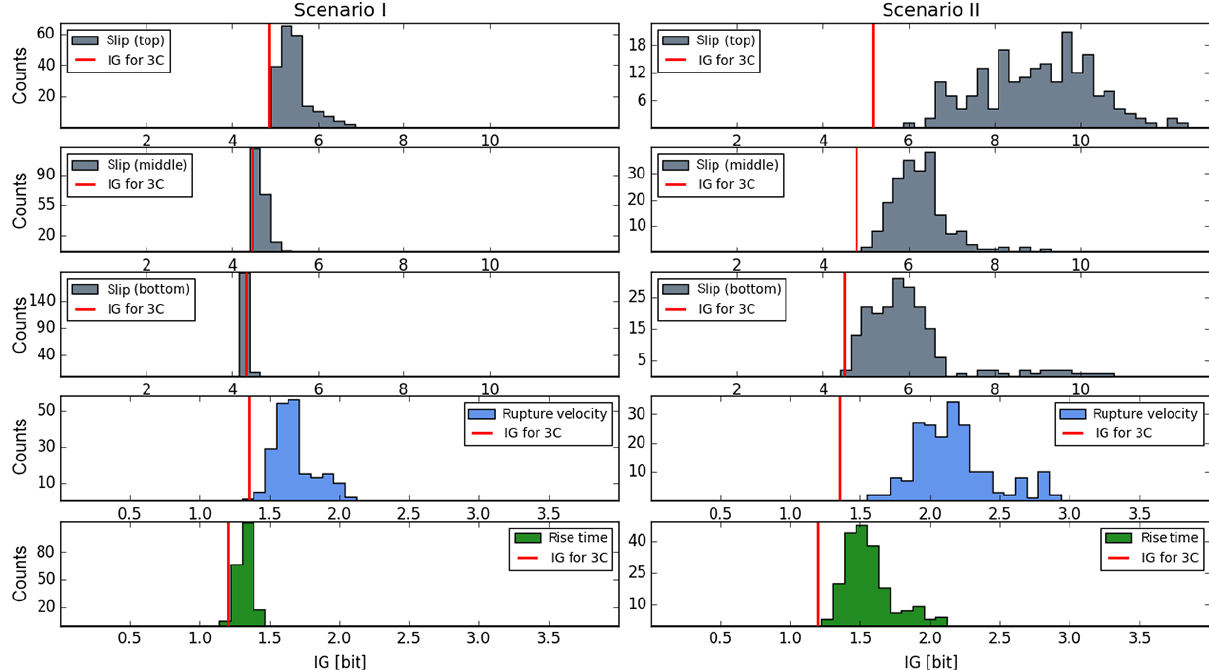
Figure 8. Histograms for the information gain for 200 inversions with random station distribution. The results for a strike-slip fault are shown in the left column and for a dip-slip fault in the right column. We add the information gain for the slip parameters row-wise to better assess the inversion quality dependence with depth. Slip (in gray), rupture velocity (in blue), and rise time (in green) are colored differently to distinguish between the three types of parameters. The statistical analysis validates the previous results. Independent of the choice of receivers (due to the random selection for each inversion) the information gain increase for the 6C inversion decreases with increasing depth; rupture velocity and rise time seem to benefit from the rotation rate data as well. Overall, the information gain increase is higher for Scenario II, even when randomizing the stations for the 6C